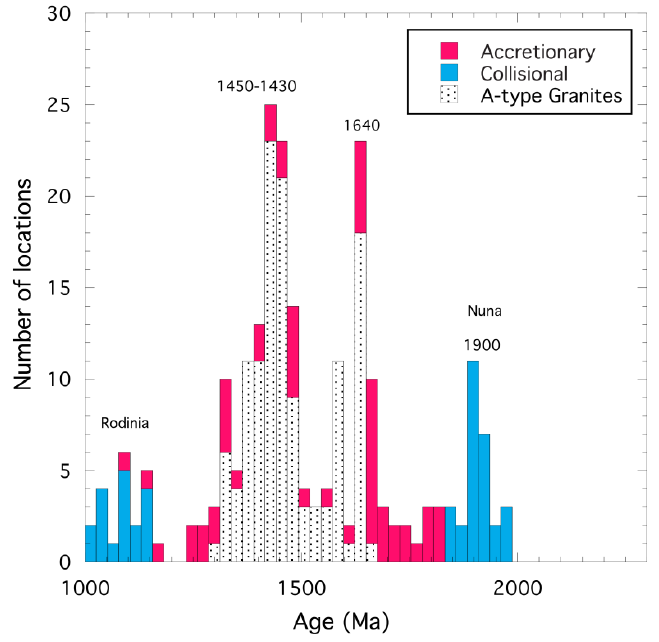
Figure 21. Frequency of Proterozoic A-type granites in Laurentia compared to distribution of accretionary and collisional phases of Proterozoic orogens in Laurentia (data from Appendix 1 and from Van Schmus et al. [40] and Goodge and Vervoort